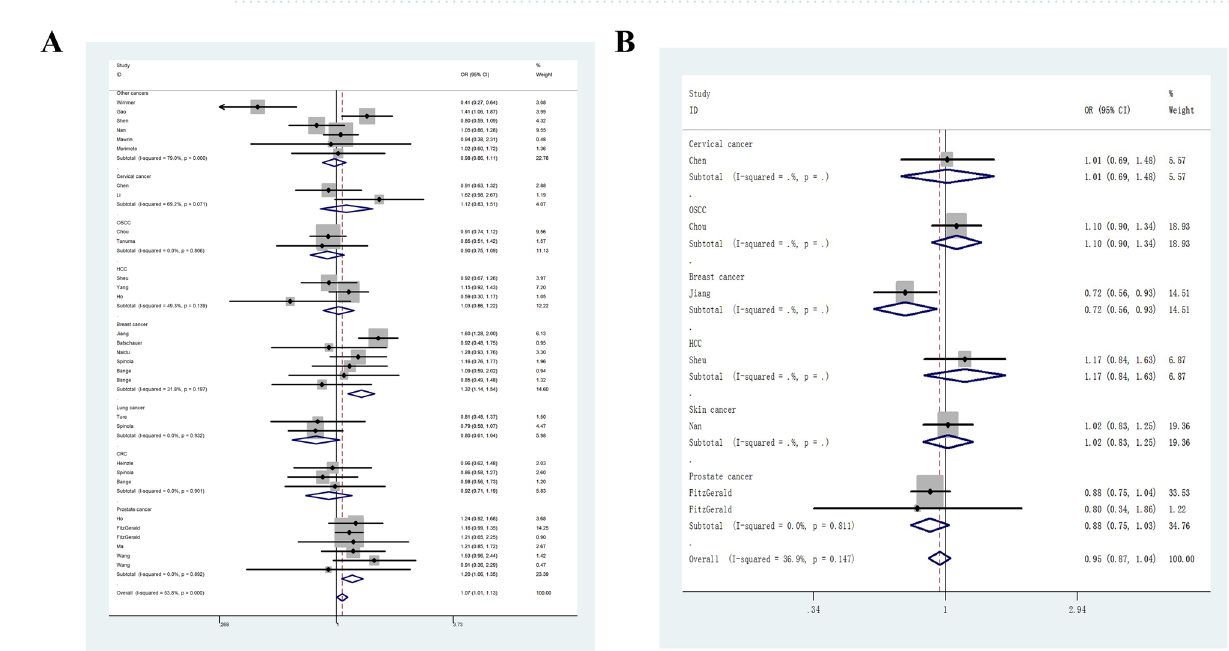
Table 2. Stratified analysis of FGFR4 G388R or V10I polymorphisms on susceptibility of cancer. CRC, colorectal cancer; HCC, hepatocellular carcinoma; HNSCC, head and neck squamous cell carcinoma; LA, Latin Americans; NA, not available; OSCC: oral squamous cell carcinoma. P heter : P value of Q -test for heterogeneity test. a Number of comparisons.